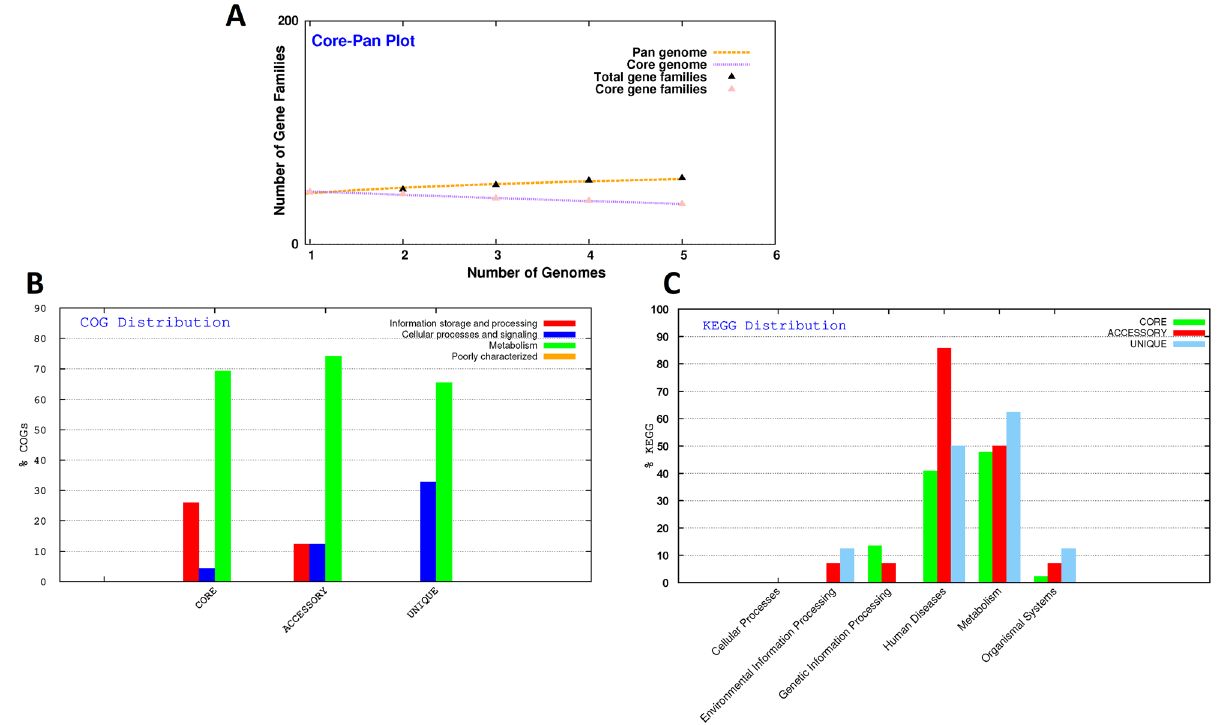
Figure 4. Pan-genome analysis ( A ), and COG ( B ) and KEGG ( C ) major category distribution of core, accessory and unique genes.